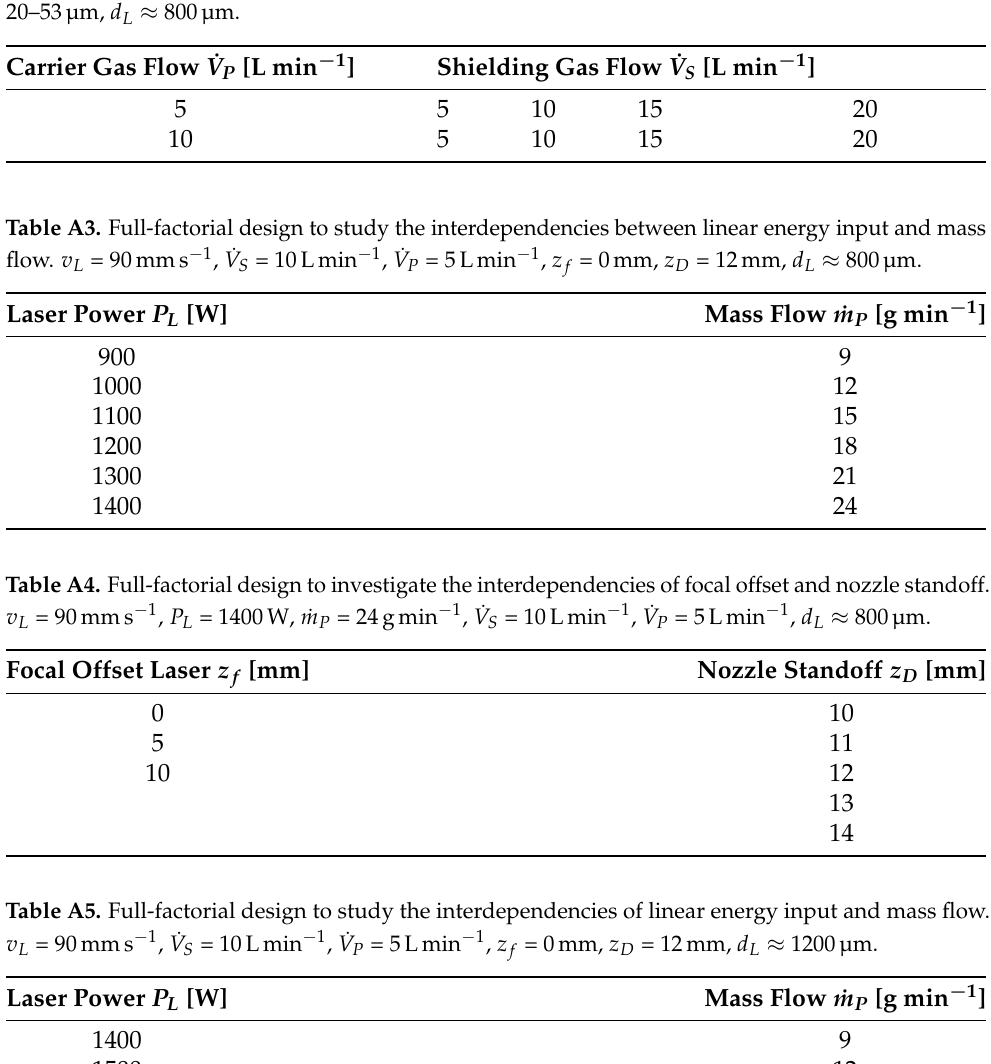
Table A2. Experimental design to investigate the influence of shielding gas flow on carrier gas